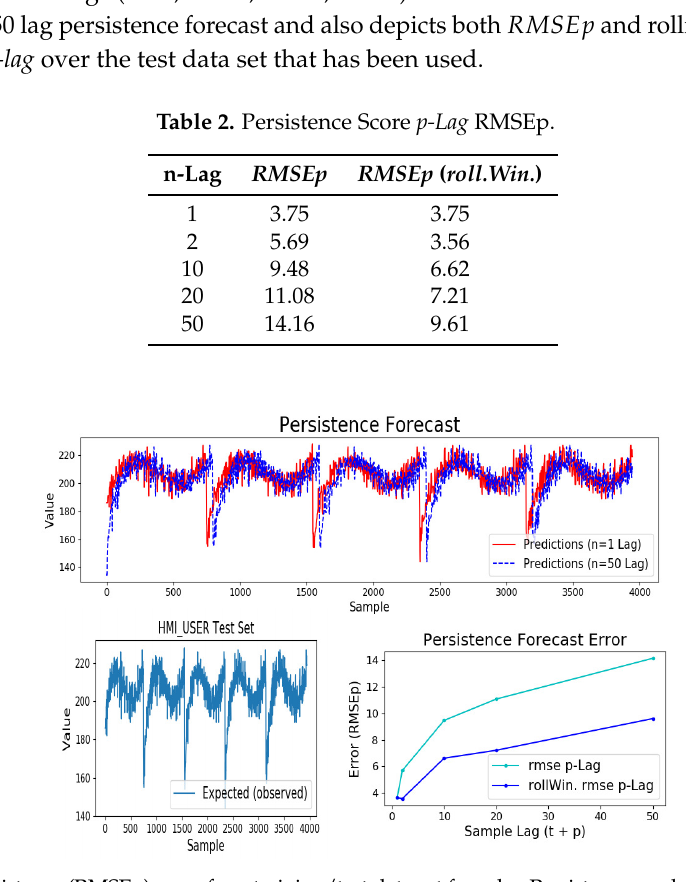
Figure 17. Persistence (RMSEp) score for a training/test data set for p -lag Persistence model forecast